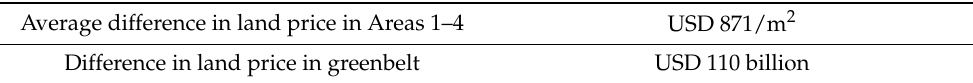
Table 6. Estimated difference in land price.